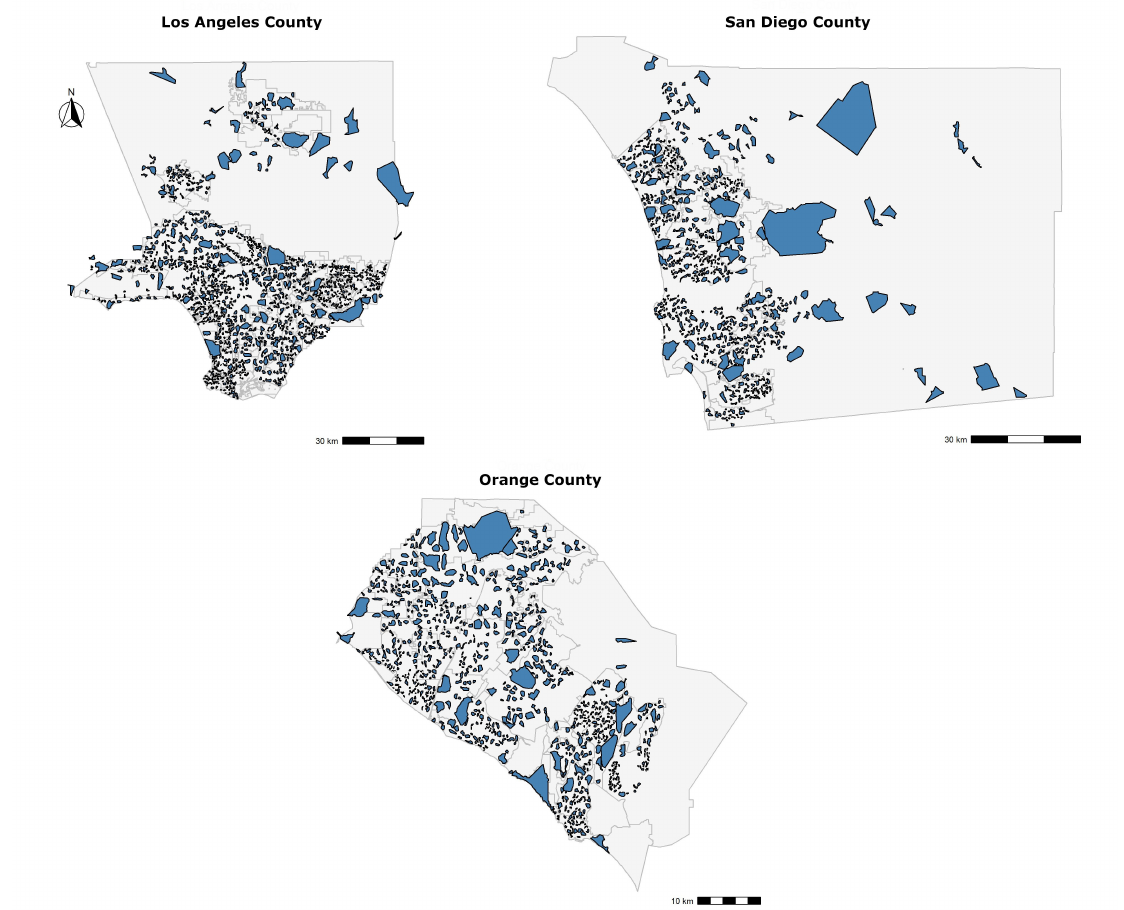
Figure 8. Delineated neighborhoods for all 3